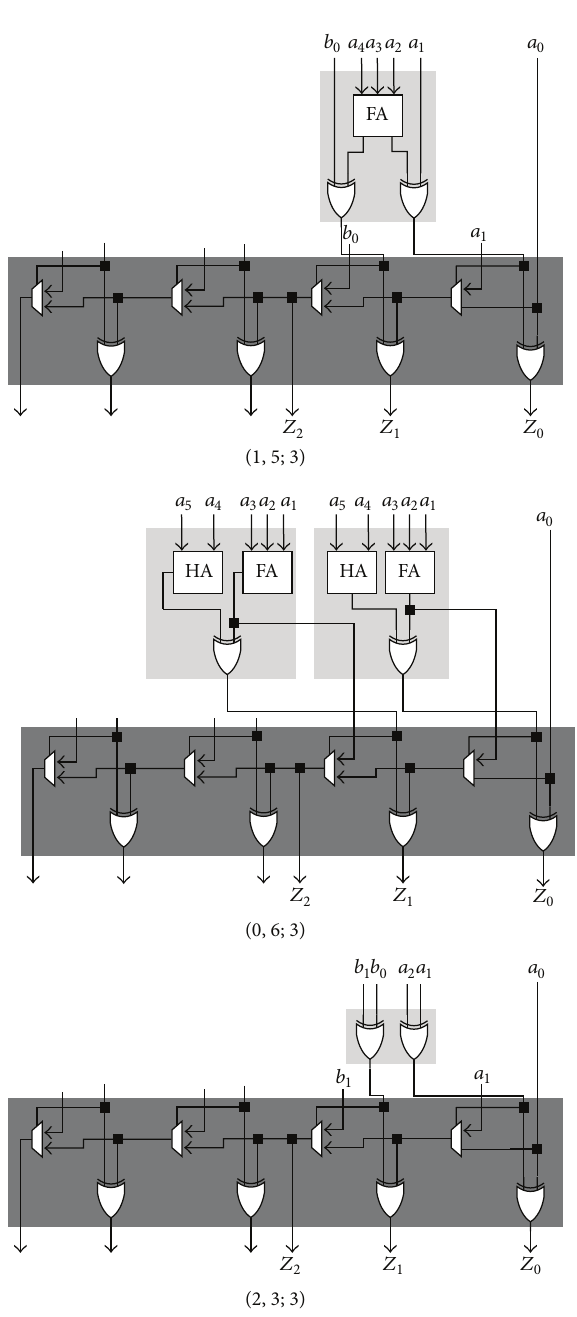
Figure 10: Area optimal mapping for different GPCs using proposed heuristic on Xilinx